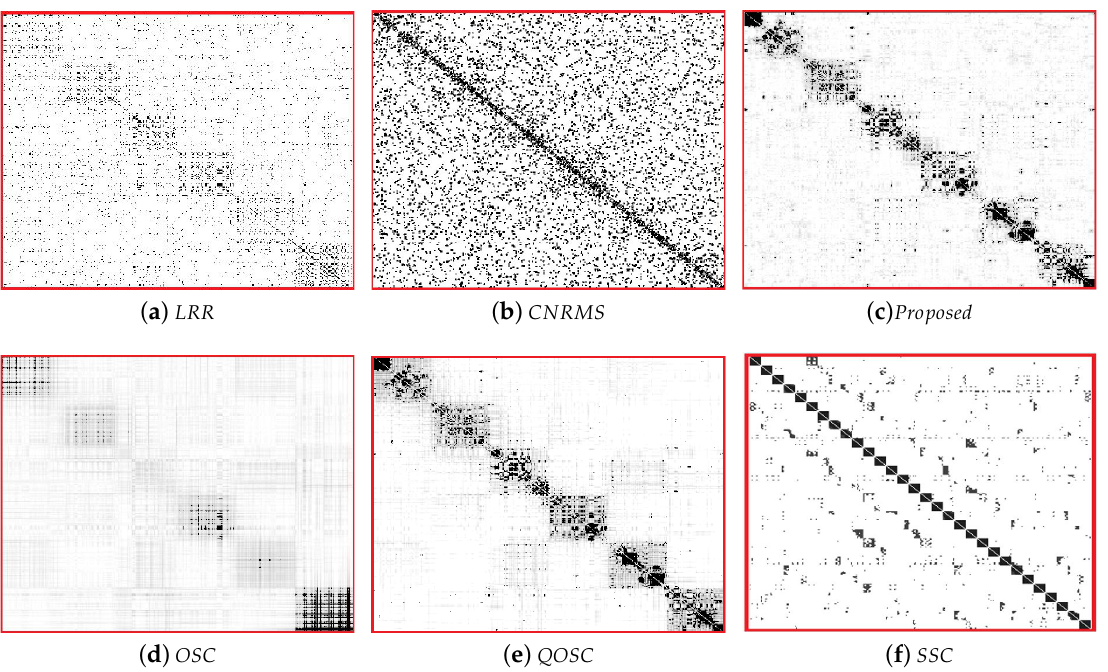
Figure 2. The visualization results of affinity matrices Z for expression clustering on the BU-4DFE dataset.